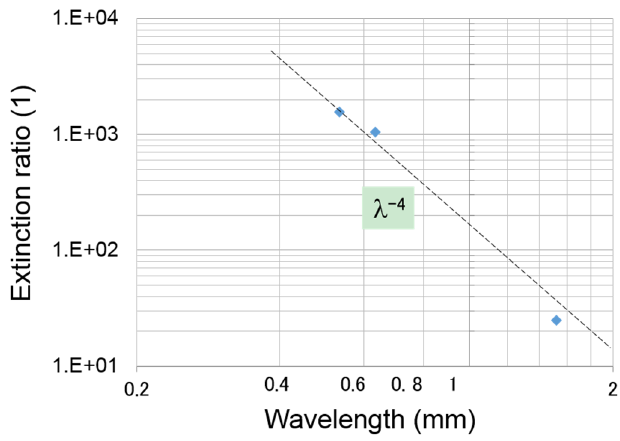
Figure 7. The extinction ratio dependence on the wavelength. Sample: SIR132.